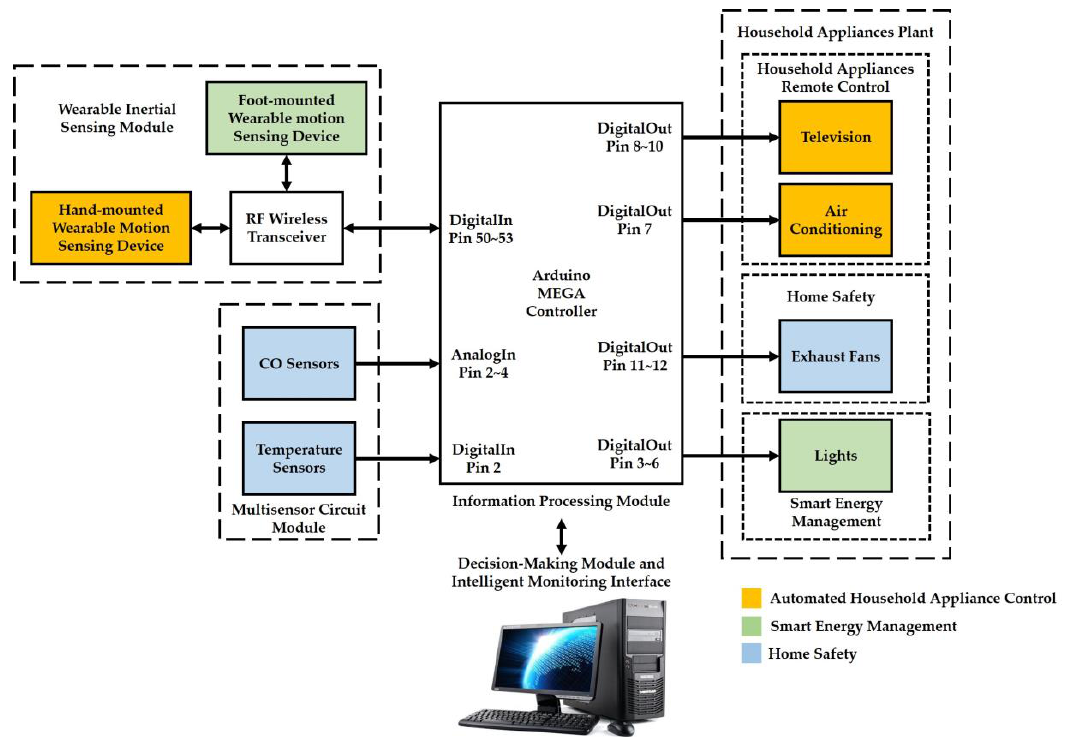
Figure 1. Overview system architecture of the proposed smart home system.